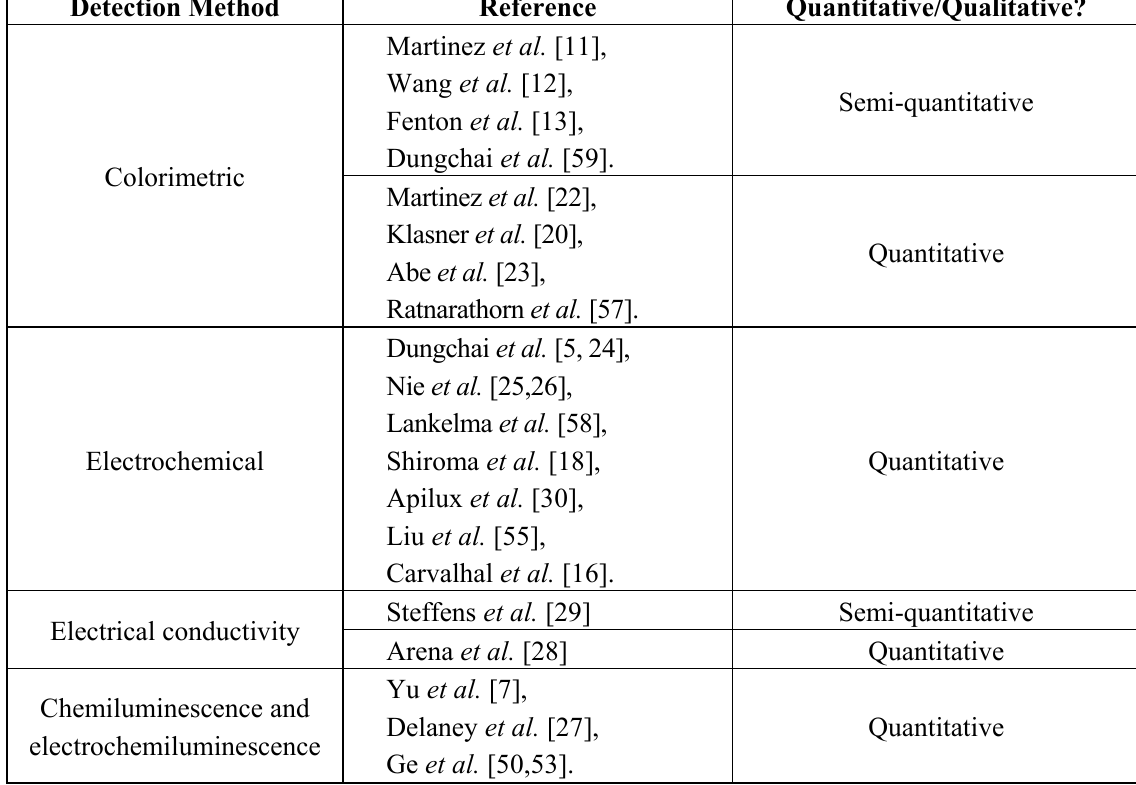
Table 1. Comparison of different analysis